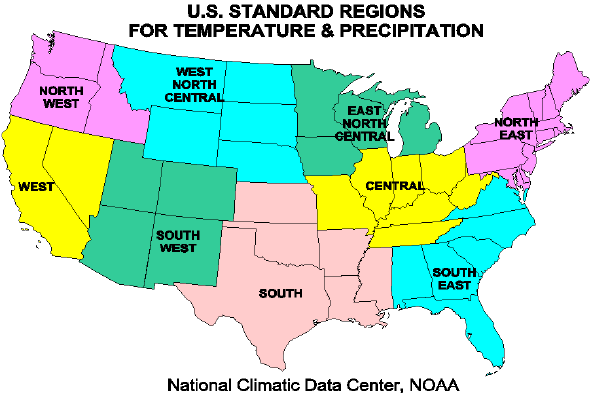
Figure 5. Map showing climatologically homogeneous regions over continental